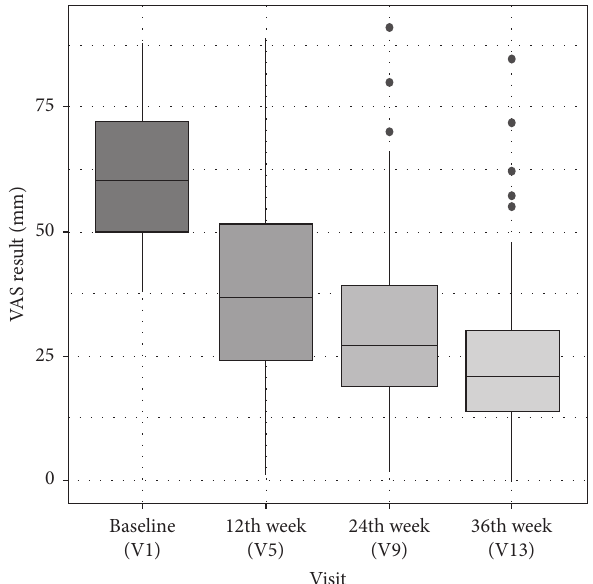
Figure 5: Pain assessment in VAS scale at visit 1, visit 5 (after 12 weeks), visit 9 (after 24 weeks), and visit 13 (after 36 weeks). Results are presented as median with interquartile range (IQR).